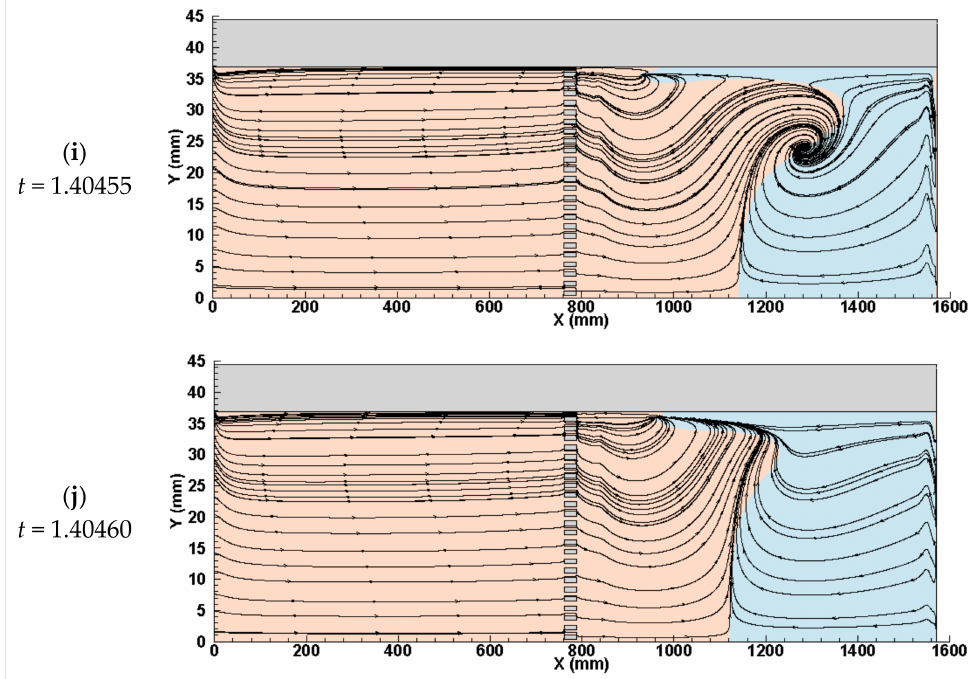
Figure 14. Axis velocity distribution in a cycle.